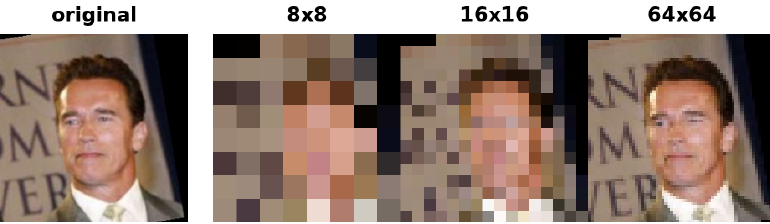
Figure 4. An example of high-resolution images (original), and the corresponding low-resolution